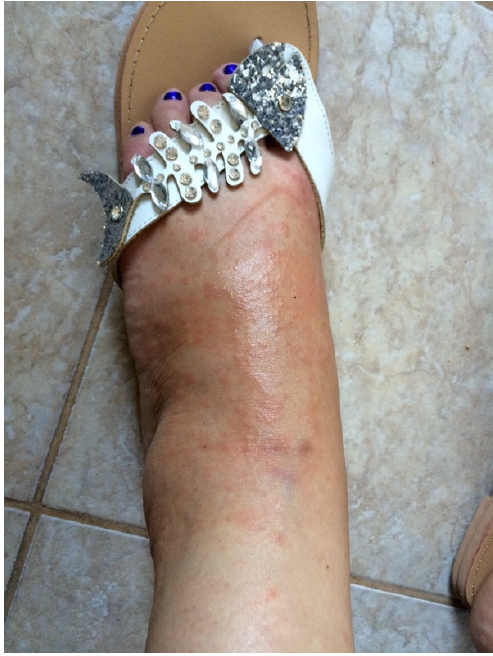
Figure 4. Confluent papules present on the feet.